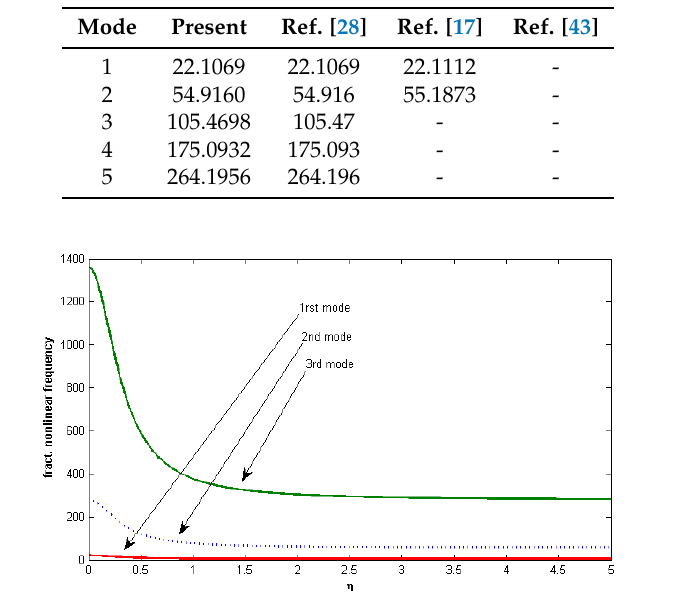
Figure 4. First three modes of the fractional nonlinear frequency versus nonlocality η ( α = 0.5, K = 5, Kp = 2, Cp = 0.001).